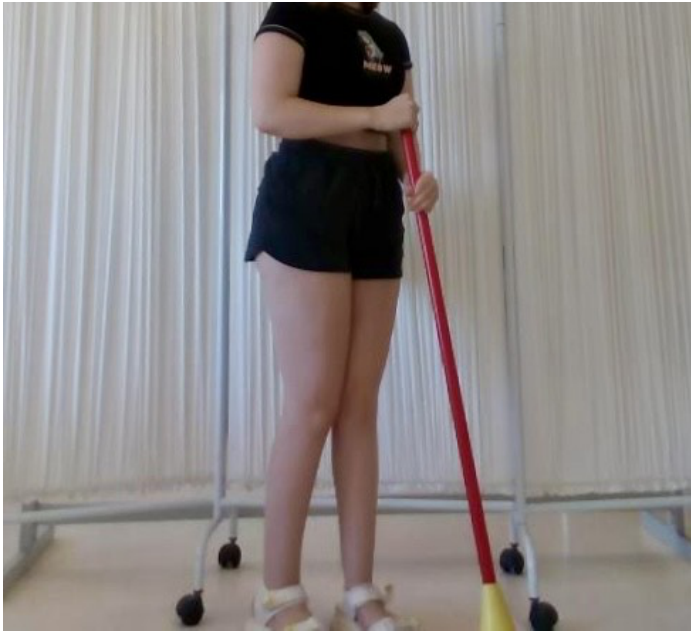
Figure 12. Mopping floor action performed by the patient